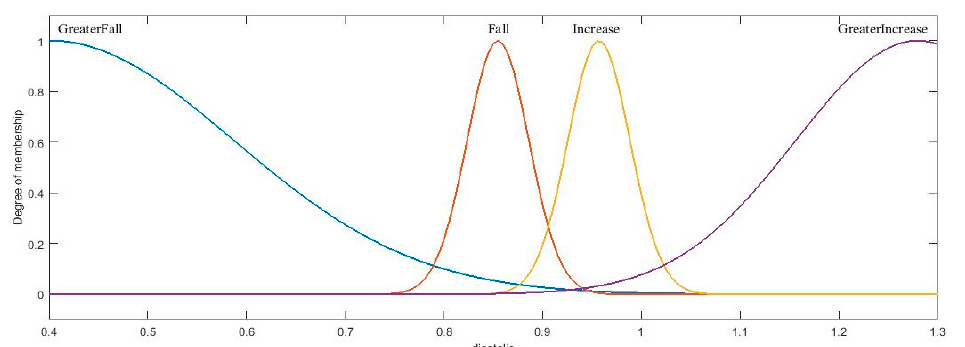
Figure 16. Diastolic quotient input.